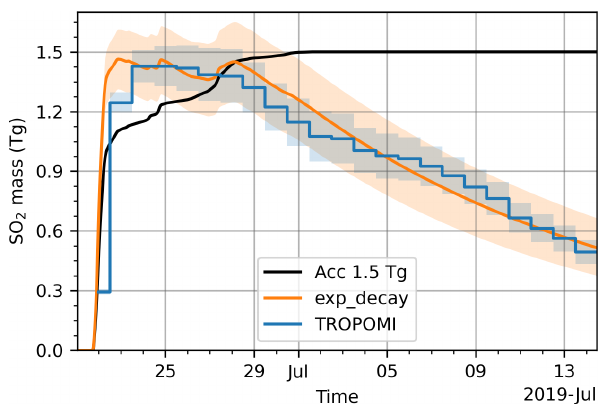
Figure 6. Temporal change of total SO 2 mass from TROPOMI measurements (blue) and calculated total mass with an e -folding lifetime of 15d (orange) and a mass scaling factor of 2 . 1 / 1 . 5. Or- ange shadings show the combination of the scaling factor ranging between 1 . 9 / 1 . 5 and 2 . 3 / 1 . 5 and an e -folding lifetime ranging be- tween 13 and 17d. The black curve shows the accumulated SO 2 injection with a total injection of 1.5Tg (the initial